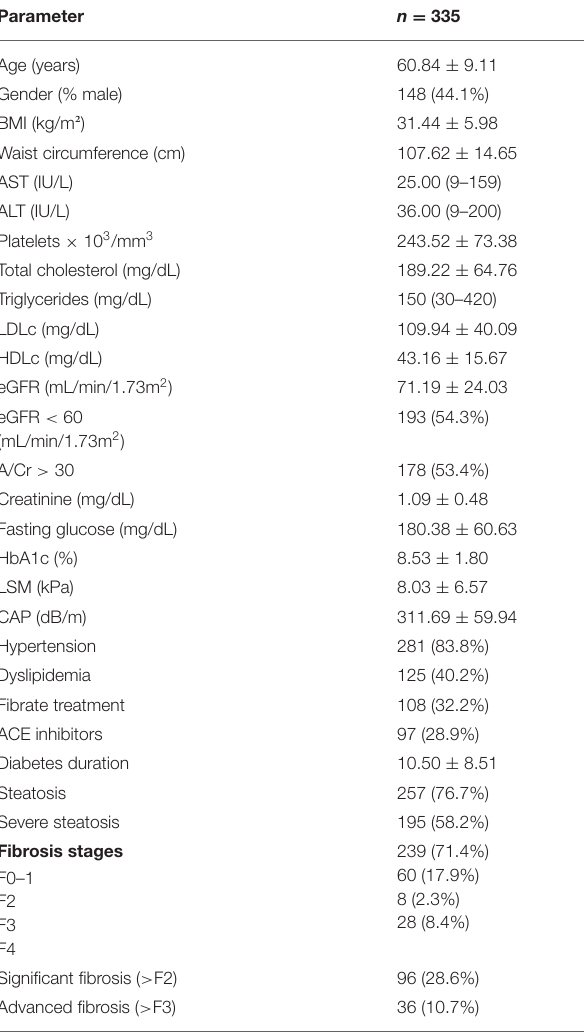
TABLE 1 | Baseline characteristics of MAFLD patients. TABLE 2 | Comparison between chronic kidney disease and non-chronic kidney disease